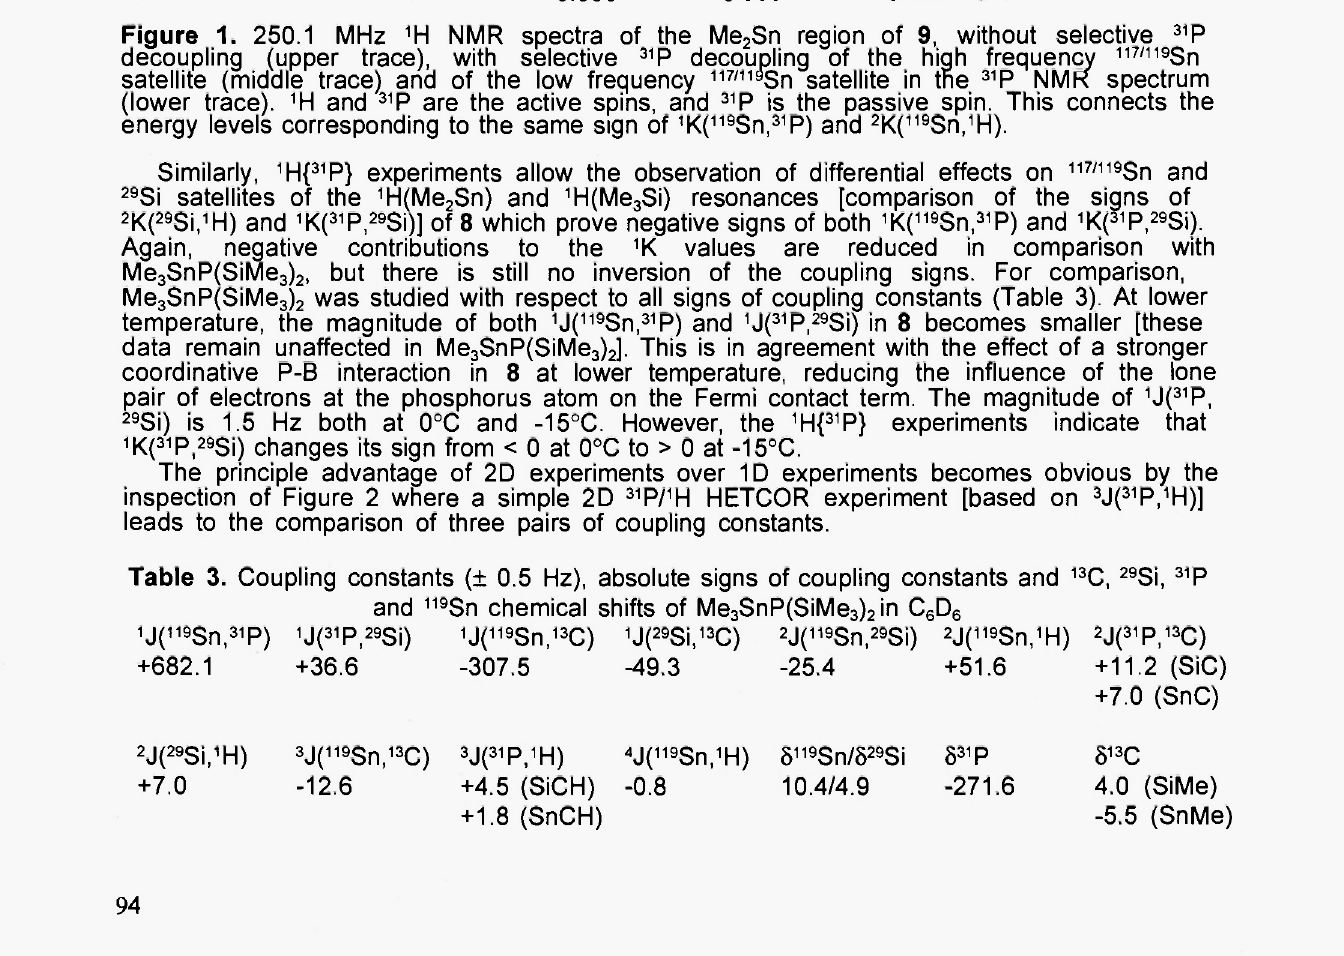
Figure 1. 250.1 MHz 1 H NMR spectra of the Me 2 Sn region of 9, without selective 31 P decoupling (upper trace), with selective 31 P decoupling of the high frequency 117/119 Sn satellite (middle trace) and of the low frequency 117/11s5 Sn satellite in the 31 P NMR spectrum (lower trace). 1 H and 31 Ρ are the active spins, and 31 Ρ is the passive spin. This connects the energy levels corresponding to the same sign of 1 K( 119 Sn, 31 P) and 2 K( 119 Sn, 1 H).